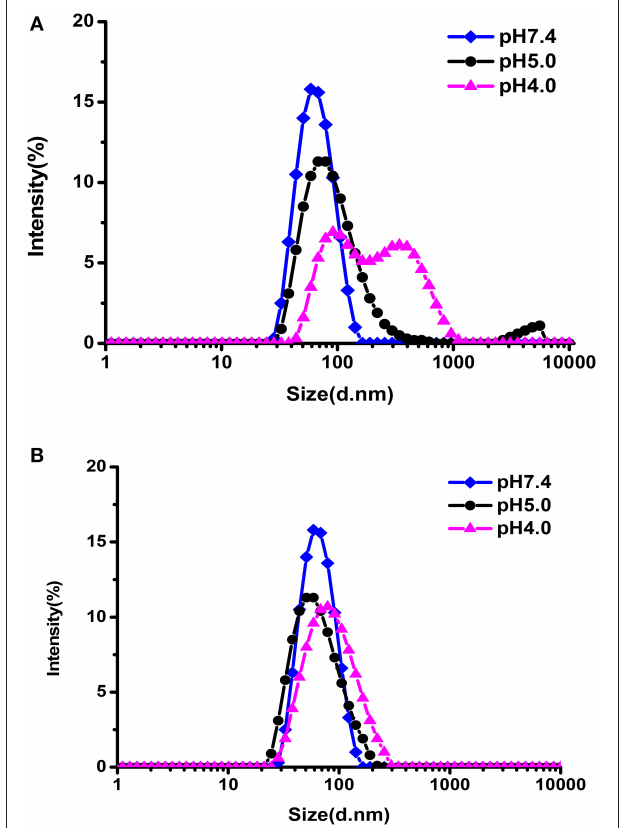
FIGURE 5 | The size change of PEG-DiHyd-PLA-18K (A) ; PLA-PEG-PLA-18K (B) micelles at different pH for 24h.